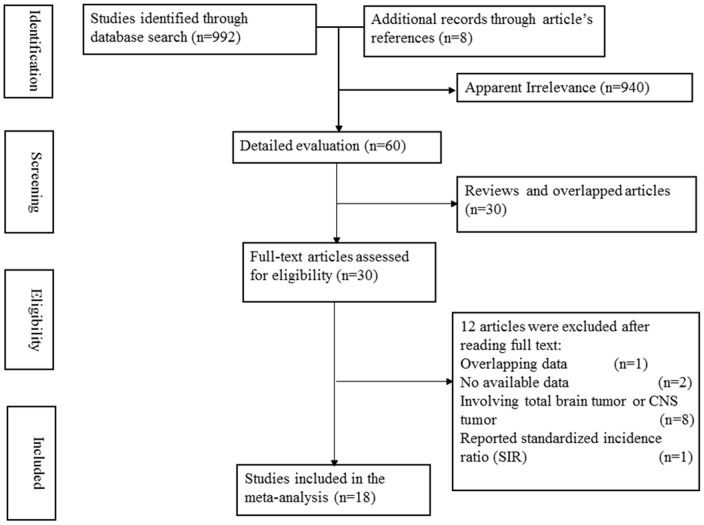
Flow diagram of literature search and selection.